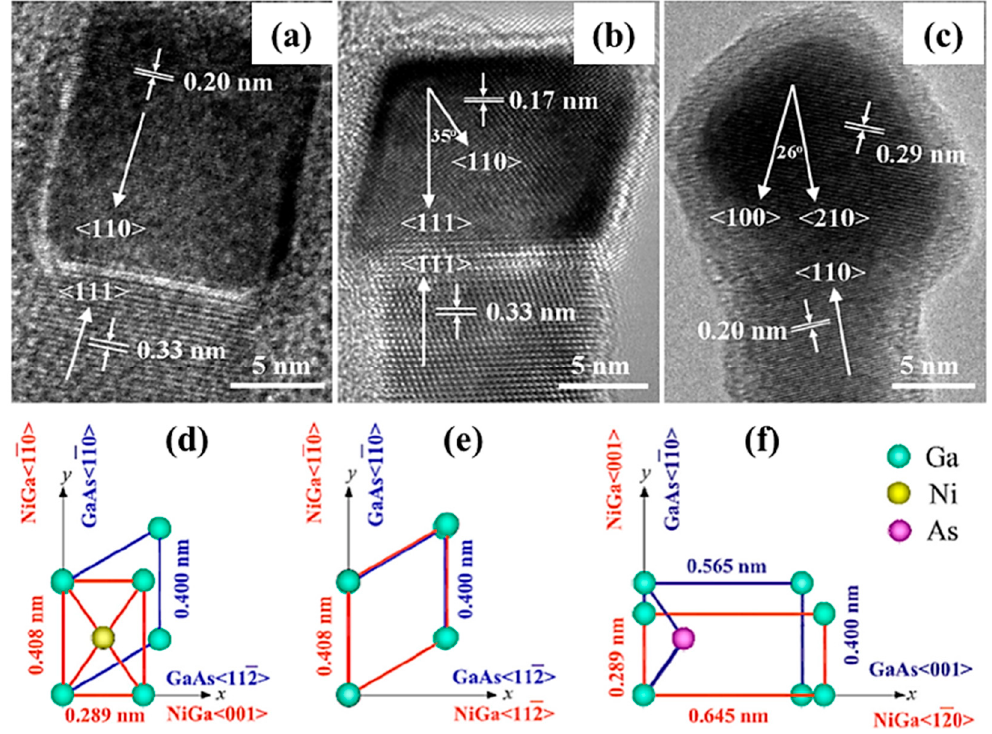
Figure 3. NiGa catalyst and GaAs NW epitaxy relationships. ( a ) NiGa(110)|GaAs(111), ( b ) NiGa(111)|GaAs(111) and ( c ) NiGa(210)|GaAs(110). ( d – f ) are the schematics of relationship in ( a – c ). Adapted with permission from [100].